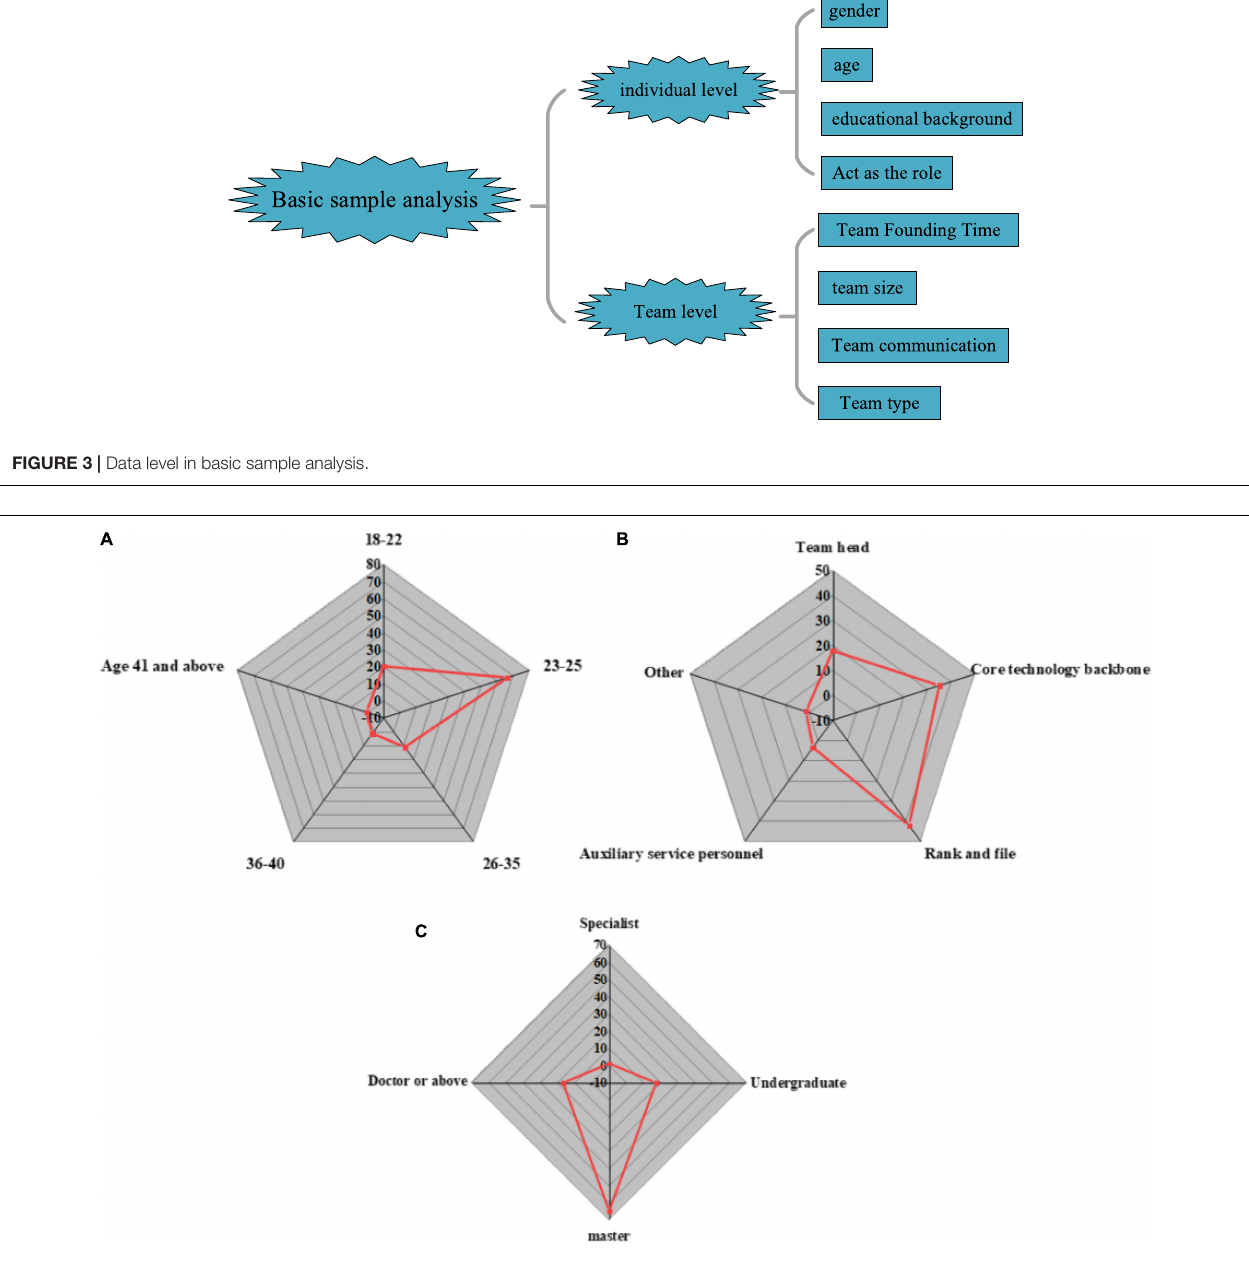
FIGURE 4 | Sample basic information at the individual level. (A) Age; (B) Team role; (C)